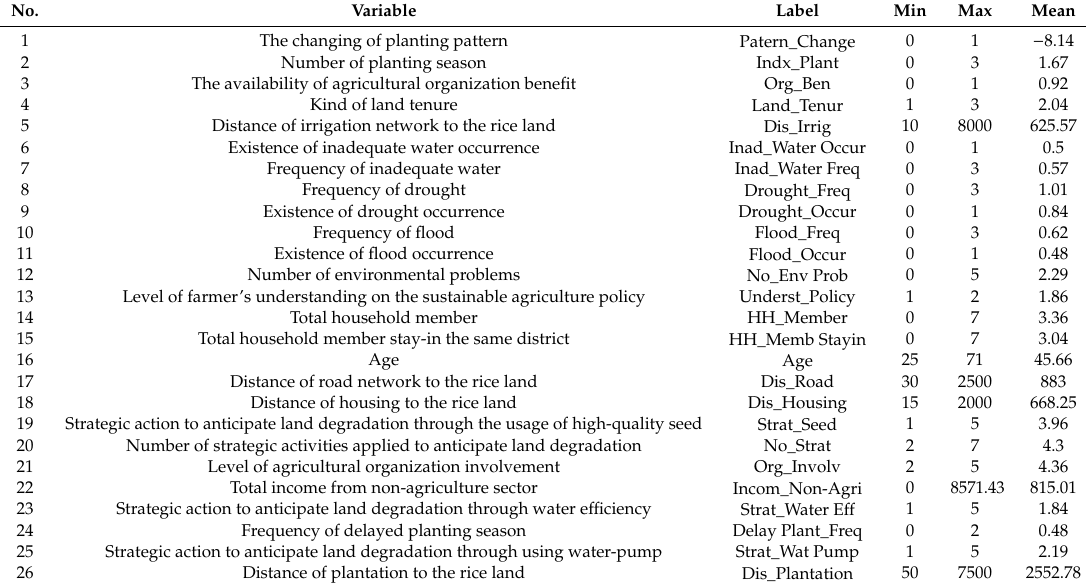
Table 10. Descriptive statistic of significant variables for rice land conversion.